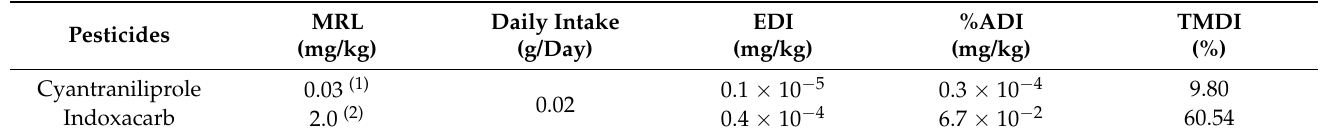
Table 5. Safety assessment of cyantraniliprole and indoxacarb in wild garlic.